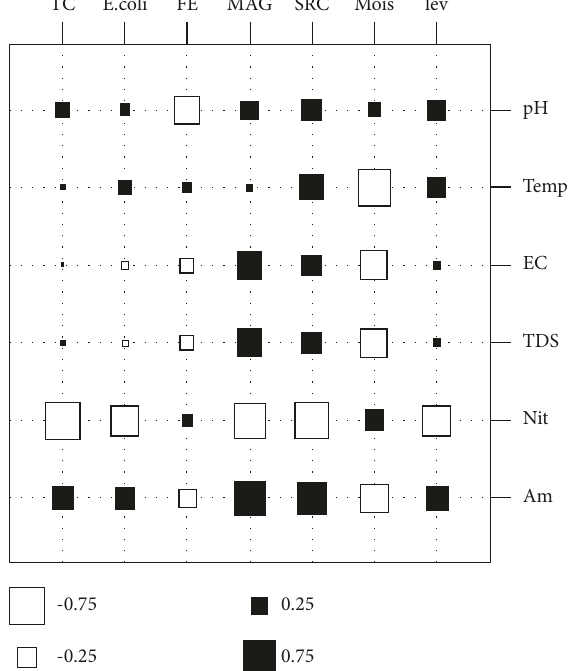
Figure 10: Correlation between physicochemical and microbio- logical